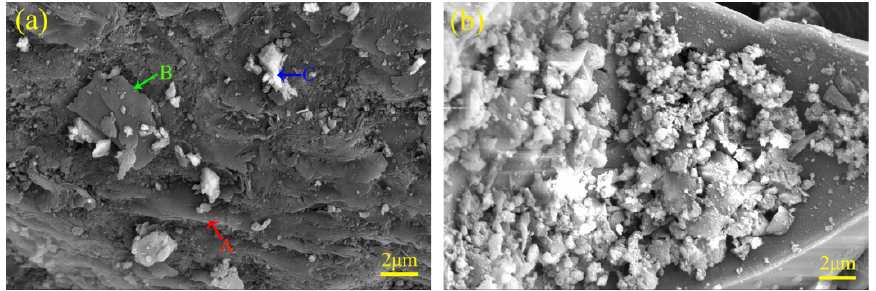
Figure 7. SEM photos of flotation products. ( a ) OPFC samples and ( b ) OPFT samples, (A,B) flakes and (C) particles.